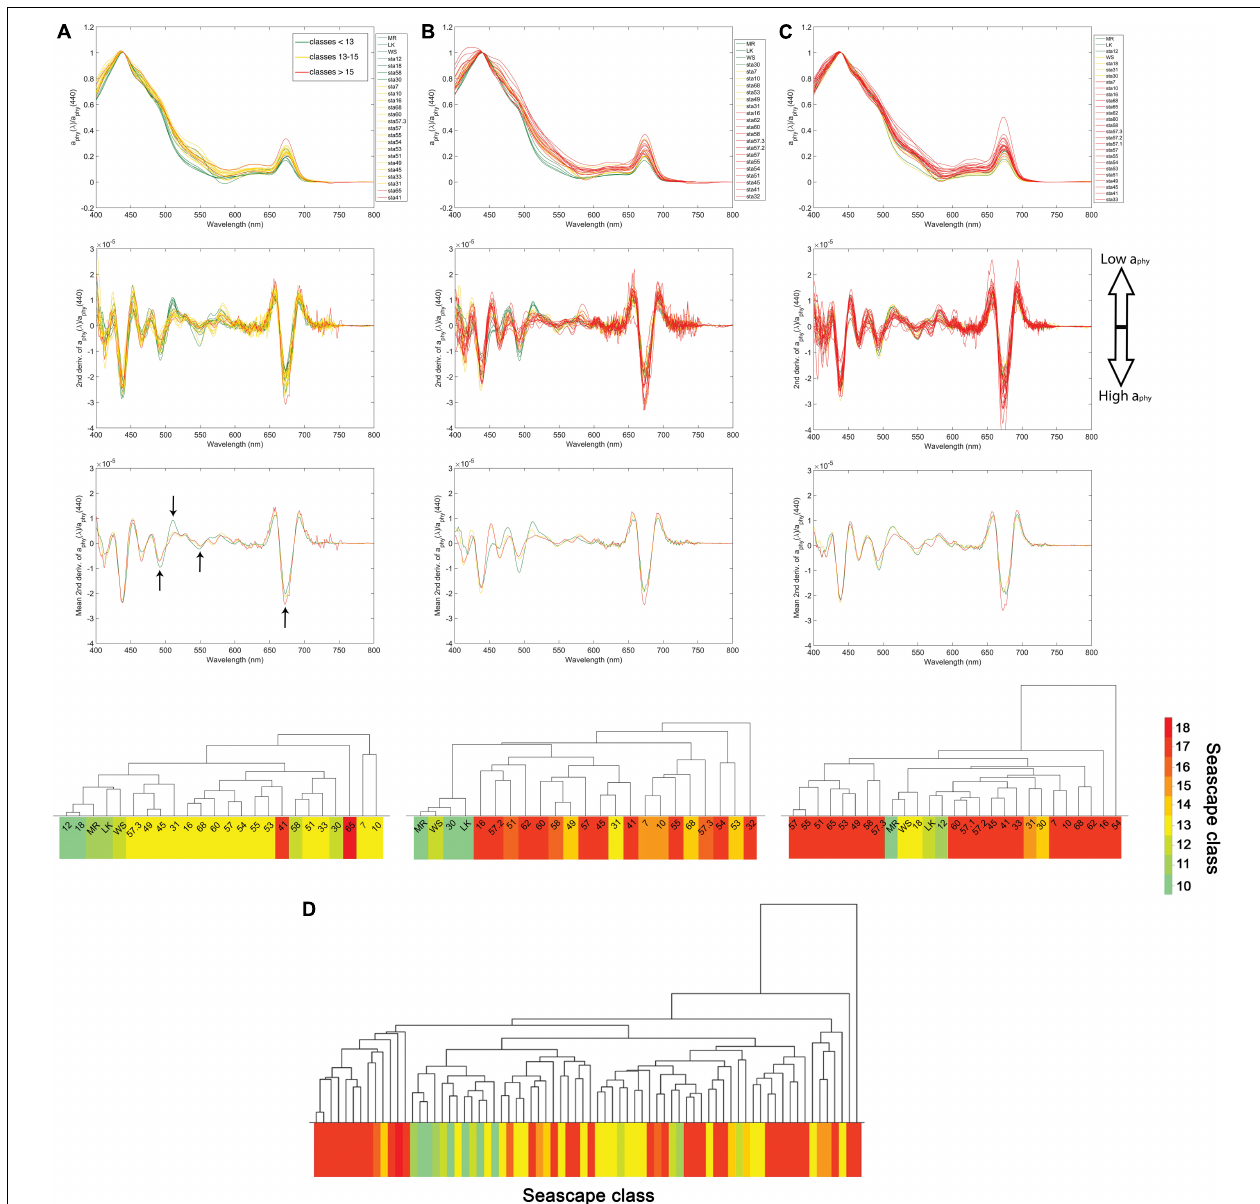
FIGURE 5 | Upper: Band-normalized phytoplankton absorption spectra [a phy ( λ )/a phy (440)] from March, May and September cruises in 2016 (A–C) , respectively) of three seascape class groups: Mesotrophic and Transition seascapes (classes 10–12) in green, Florida Bay, and Nearshore seascapes (classes 13–15) in yellow, and Optically Shallow seascapes (classes 16–18) in red. Middle: Second derivative of a phy ( λ )/a phy (440) for corresponding cruises for all sampled sites and averaged by seascape class. Lower: Dendrogram clustering of sampled stations derived from HAC analysis of second derivative of a phy ( λ )/a phy (440) for each sampling period. Dendrogram labels correspond to station ID’s shown in Figure 1 . Bottom dendrogram (D) shows groupings of second derivative of a phy ( λ )/a phy (440) spectra using data from all sampling periods combined. Dendrogram leaves are color coded according to seascape class identified in each station during corresponding cruises. Black arrows indicate a phy ( λ )” troughs at 492, 550, and 673 nm, and the a phy ( λ )” peak at